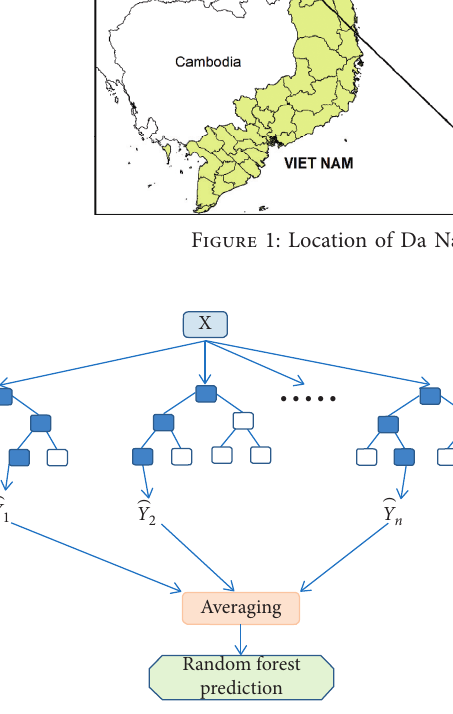
Figure 2: Random forest (RF) structure.